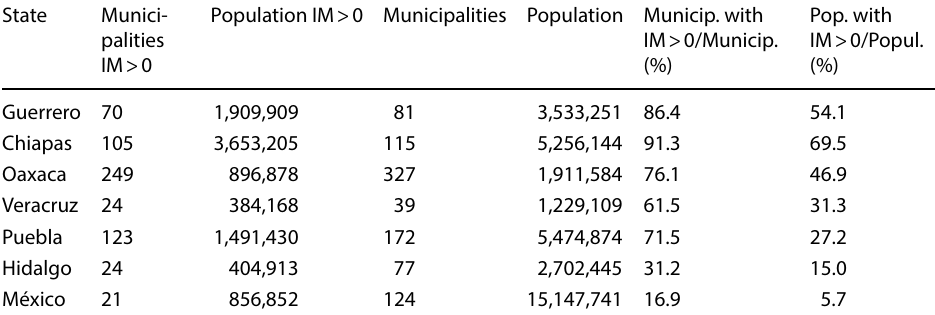
Table 3 Demographics and IM of the municipalities of the states analysed